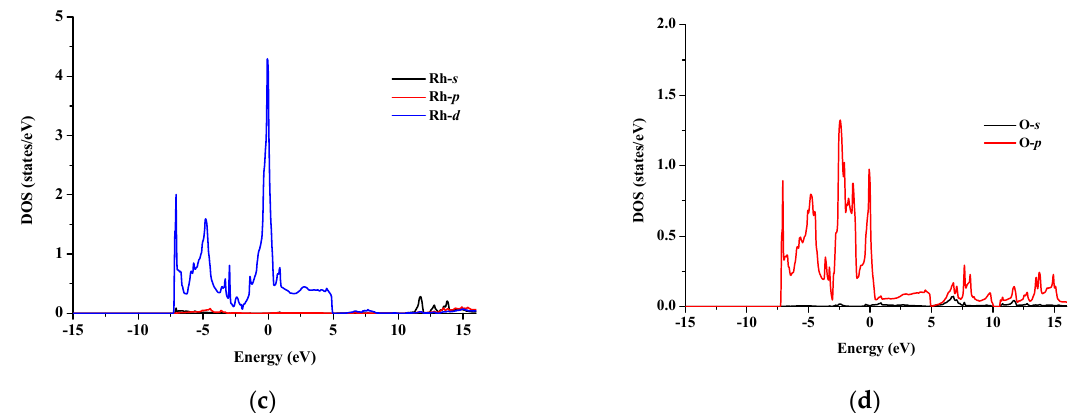
Figure 5. ( a ) Total density of states of SrRhO 3 compound and partial density of states for ( b ) Sr atom, ( c ) Rh atom and ( d ) O atom in SrRhO 3 compound.